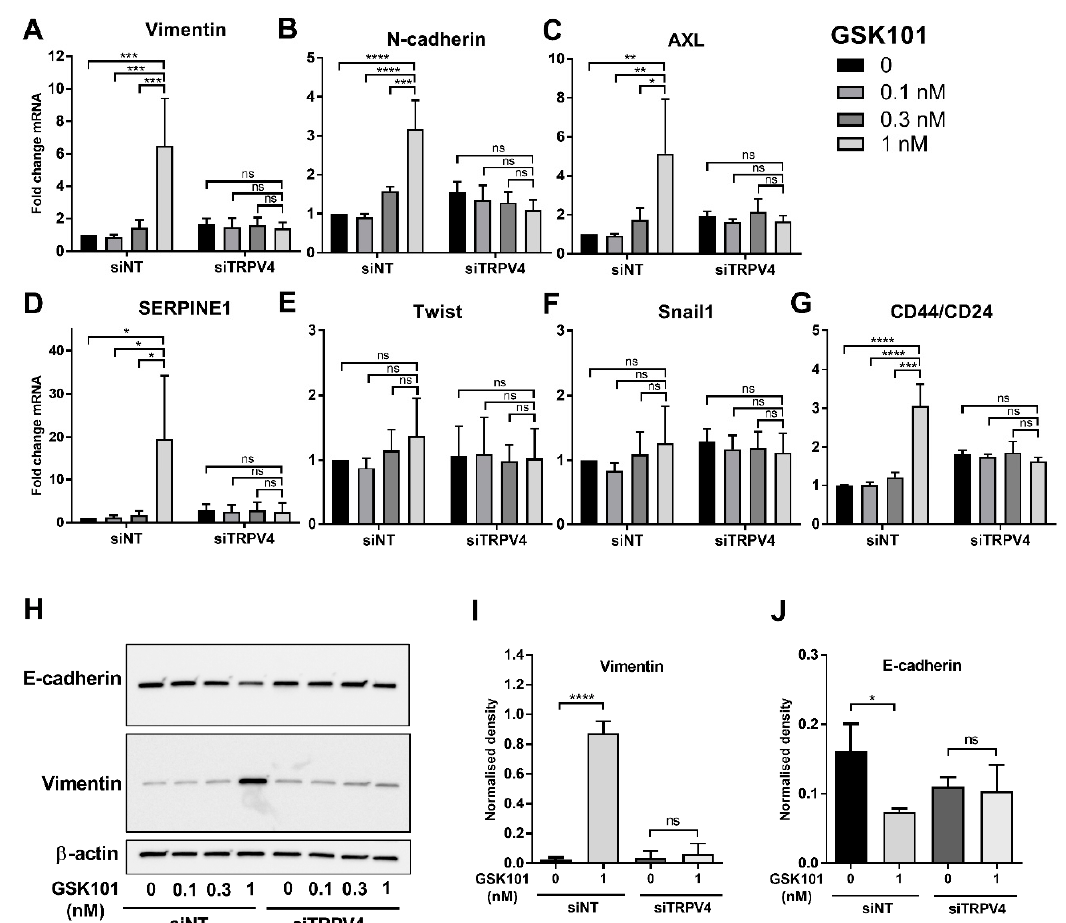
Figure 3. TRPV4 activation promotes EMT in MDA-MB-468 cells. ( A – G ) The effect of TRPV4 pharmacological activator, GSK1016790A (GSK101), on the mRNA expression of EMT markers in